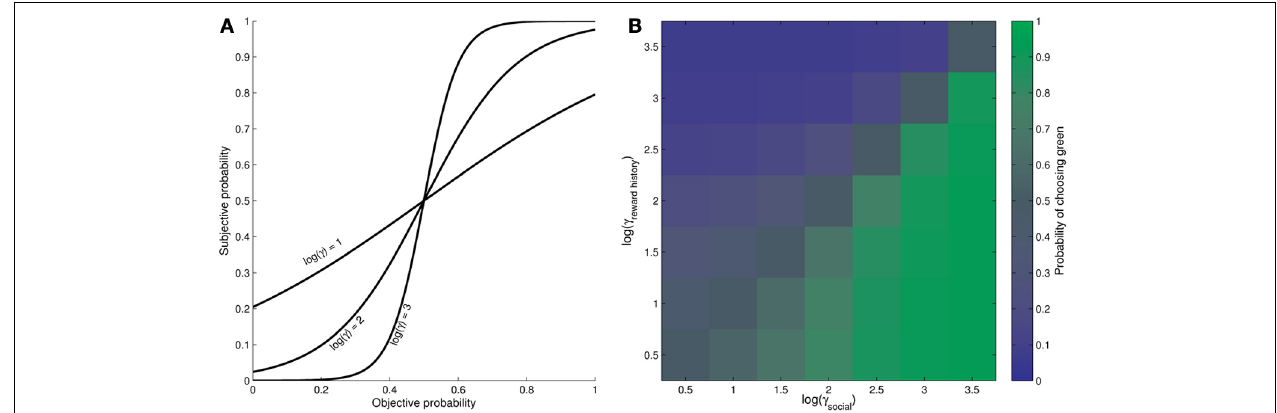
γ γ reward history and social , for one example trial, where reward history and advice are equally relevant, but suggest conflicting responses (reward history suggests blue choices, advice is to pick green). When = γ γ social reward history (diagonal), subject is equally likely to pick blue or green; when γ social > γ reward history , subject is more likely to pick green; when γ social < γ reward history , subject is more likely to pick blue. See section Modeling for